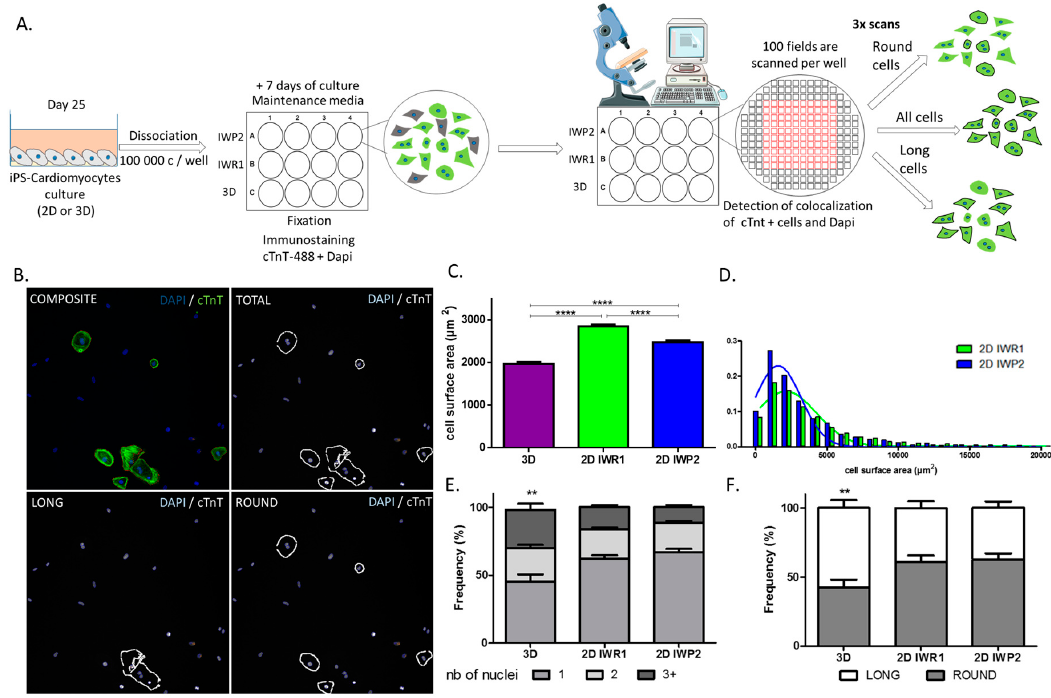
Figure 2. High content cell imaging to analyze the cell size, nucleation and morphology using the cTnT and Dapi staining. ( A ) Design of the automated cellular imaging high content analysis; ( B ) Composite image of the detection of cTnT+ and Dapi+ cells. Detection setting for total, round and long cells ( C ) Cell surface comparison at day 27 ± 2. N > 1500 cells from at least three different differentiations with three different iPSC clones, **** p < 0.0001; ( D ) Distribution of cell surface area in generated cTNT+ cells from the 2D-IWR1 (green) and 2D-IWP2 (blue); ( E ) Frequency of number of nuclei in the total cells for each protocol ( F ) Distribution of round and long cells obtained with each protocol. ** p < 0.01.